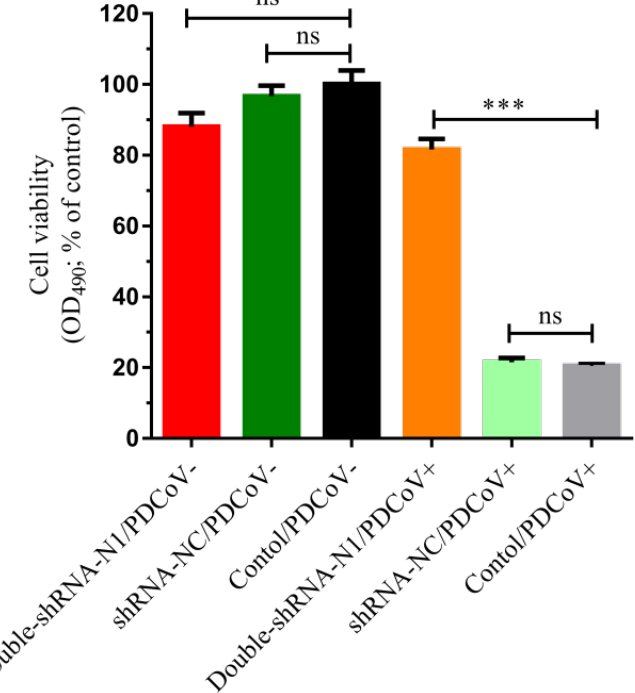
Figure 7. The viability observation of LLC-PK1 cells transfected with double-shRNA-N1-Mcherry during PDCoV infection. The cells were transfected with pSil-double-shRNA-N1-mCherry and then infected with PDCoV at an MOI of 0.1. At 36 hpi, the cell viability was calculated using the MTS assay, and the data are marked with three asterisks (***) if p <